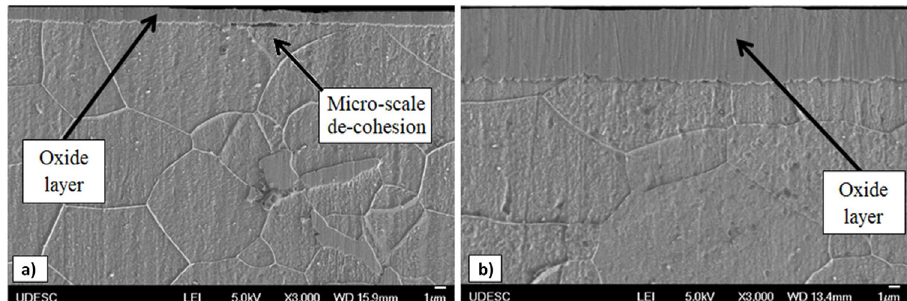
Figure 3. Cross section images of oxide layers (SEM): a) sample O300-2h; b) sample O500-0,5h.